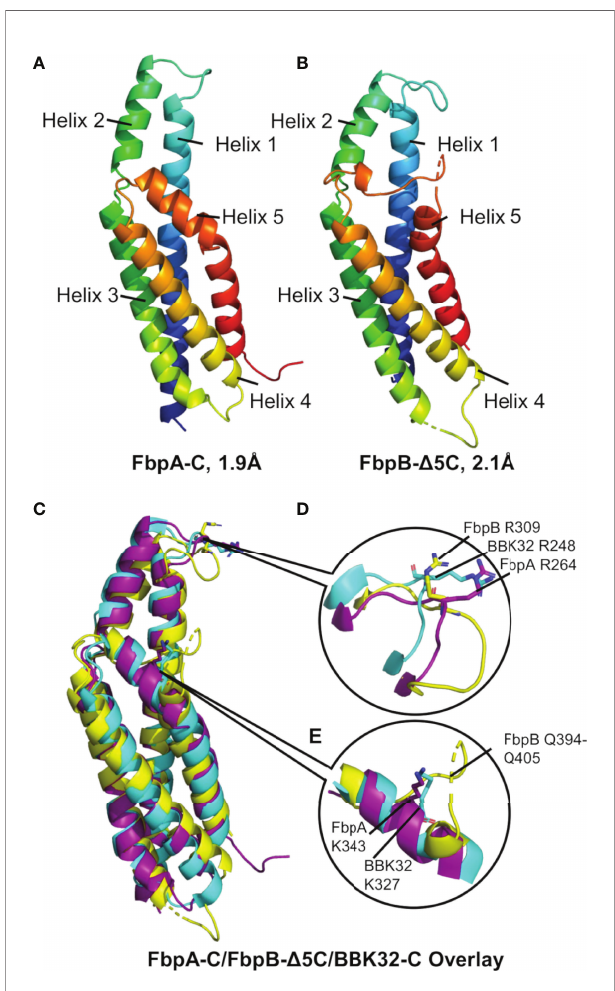
FIGURE 5 | The crystal structures of B. miyamotoi FbpA-C and FbpB- D 5C. Crystal structures of (A) FbpA-C (PDB Code: 7RPR) and (B) FbpB- D 5C (PDB Code: 7RPS) were solved to a limiting resolution of 1.9Å and 2.1Å, respectively. Both FbpA-C and FbpB- D 5C are shown as a color spectrum where blue represents the N-terminus and red represents the C-terminus. (C) A structural alignment of FbpA-C (purple), FbpB- D 5C (yellow), and B ) burgdorferi BBK32-C (cyan, PDB Code: 6N1L). (D) Each protein is structurally similar near the functionally critical BBK32-R248 residue (i.e., FbpA-R264 and FbpB-R309). (E) Differences between BBK32-C, FbpA-C, and FbpB-C are found at the functionally critical BBK32-K327 residue (K343 in B miyamotoi FbpA). FbpB- D 5C shows an altered secondary structure with an extended loop structure corresponding to residues Q394-Q405 that